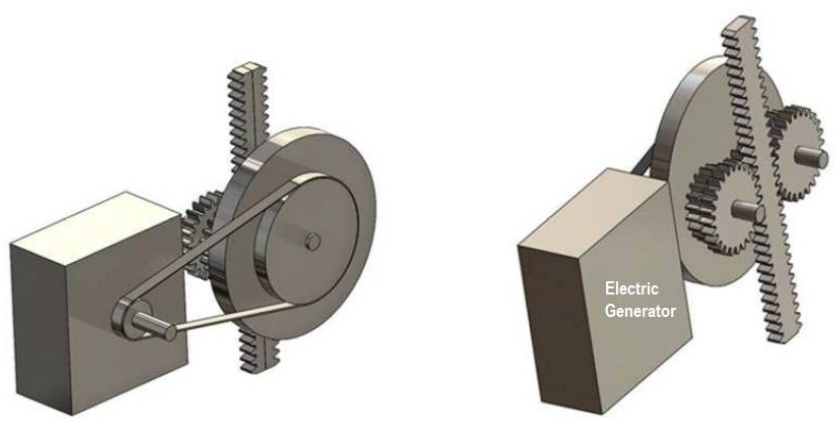
Figure 2. The speed hump mechanical system with the connected